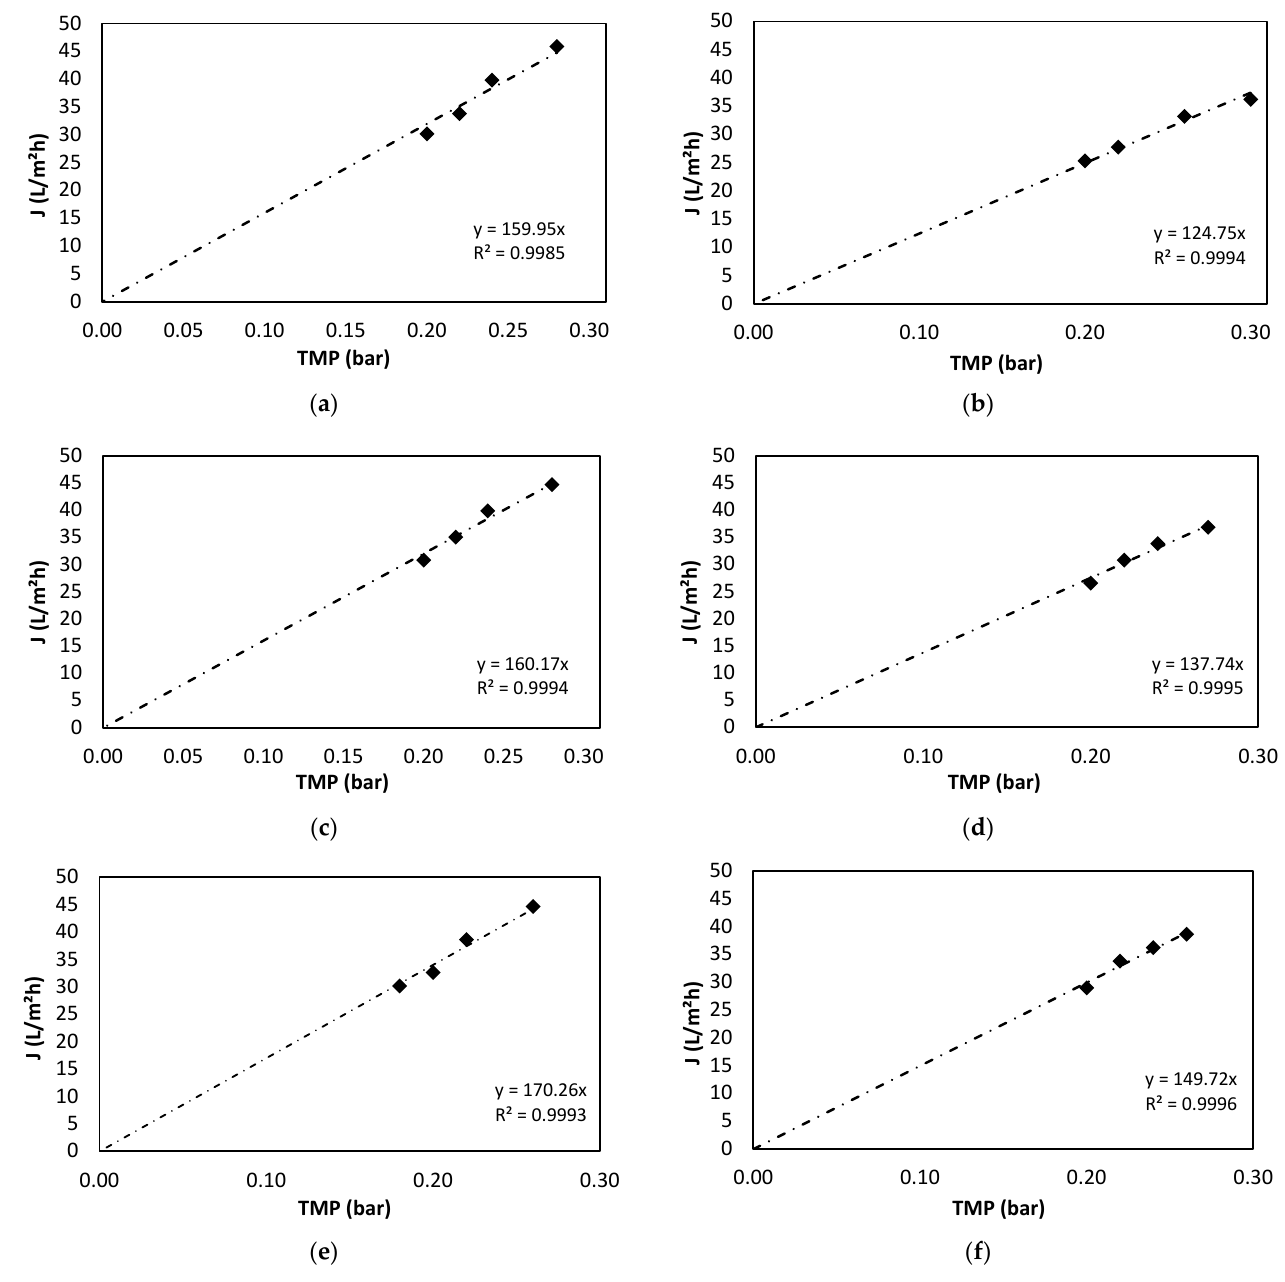
Figure 7. Fitting the permeate flux (J) and TMP data at different temperatures to the linear part of the per-formance model. ( a ) Clean membrane at 20 ◦ C. ( b ) Soiled membrane at 20 ◦ C. ( c ) Clean mem-brane at 25 ◦ C. ( d ) Soiled membrane at 25 ◦ C. ( e ) Clean membrane at 30 ◦ C. ( f ) Soiled membrane at 30 ◦